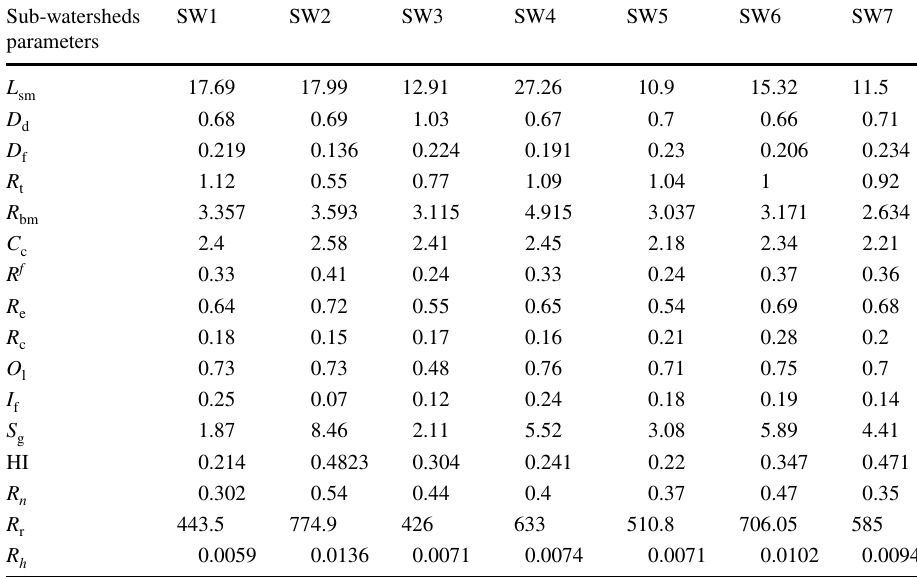
Table 4 Value of morphometric